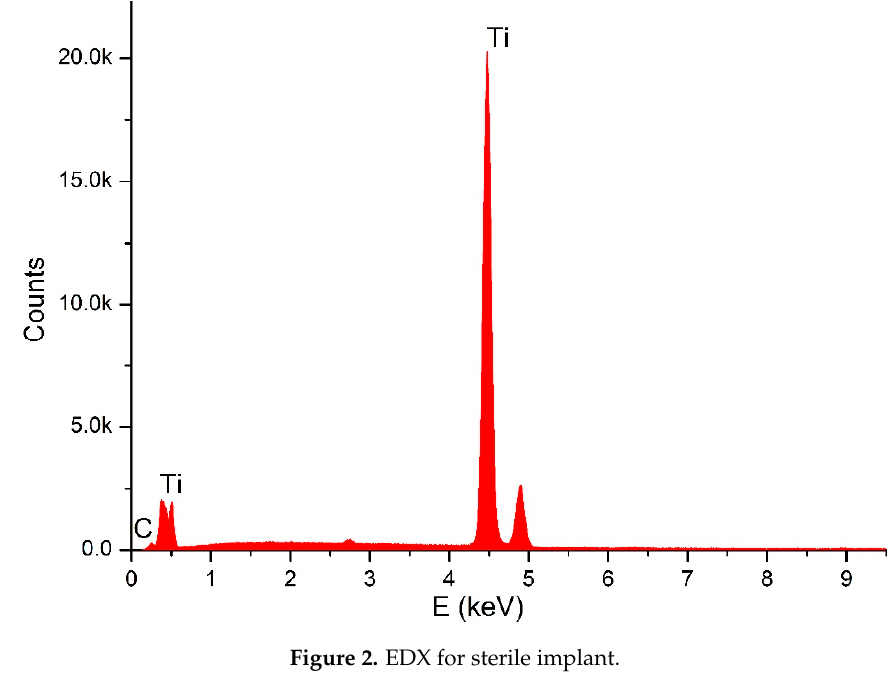
Figure 2. EDX for sterile implant.